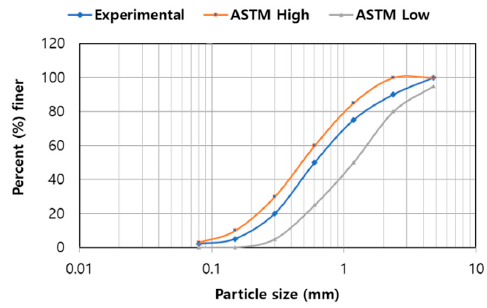
Figure 4. Gradation curves for fine aggregate and American Society for Testing and Materials (ASTM) C33 grading requirements for fine aggregate.